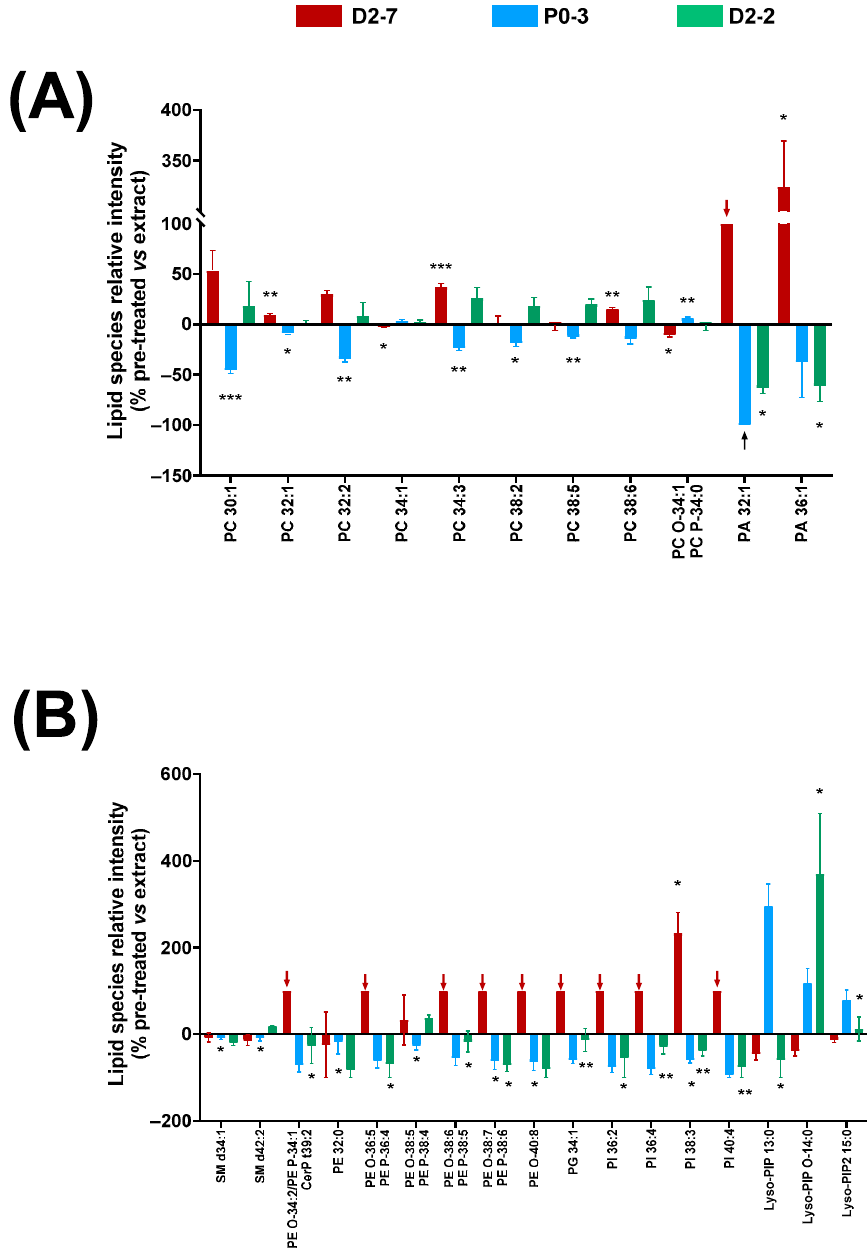
Figure 6. Changes in lipid fingerprint due to α -tocopherol pre-treatment in cell homogenates of cells exposed to Cannabis sativa plant extracts, expressed as percentage of the relative intensity of each extract, compared to the control condition. ( A ) Glycerophospholipids (PC, PC-O, PC-P, and PA). ( B ) Sphingolipids and glycerophospholipids (SM, CerP, PE, PE-O, PE-P, PG, PI, Lyso-PIP, and Lyso- PIP2). Normality was tested for each lipid species separately by Bartlett test; α was set at 0.05. Student t-test or Wilcoxon test were performed on the parametric and non-parametric samples, respectively. The tests were two-tailed and α was set at 0.05. p -value < 0.05 (*); <0.01 (**); and <0.001 (***). Black arrows indicate absence of a lipid species in this sample. Abbreviations: glycerophosphocholine, ether and plasmalogen forms—PC, PC-O, and PC-P; glycerophosphatidic acid—PA; sphingomyelin—SM; ceramide phosphate—CerP; glycerophosphoglycerol—PG; glycerophosphoethanolamine, ether form and plasmalogen form—PE, PE-O, and PE-P; glycerophosphatidilinositol—PI; lysophosphoinositol phosphate—Lyso-PIP; and lysophosphoinositol bisphosphate—Lyso-PIP2.